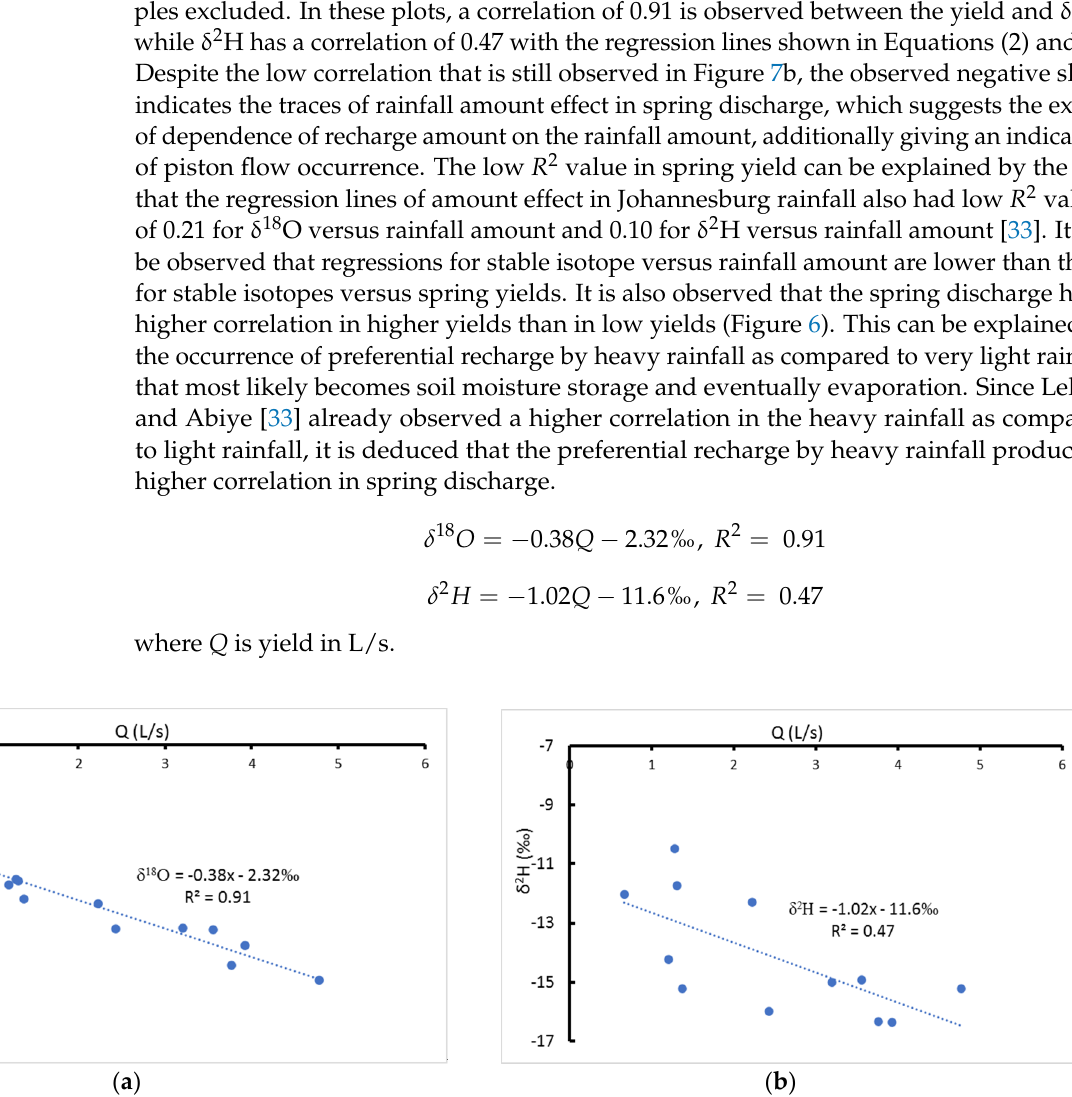
Figure 7. Plots of spring yield versus stable isotopes excluding outlier samples with ( a ) showing a correlation between yield and δ 18 O and ( b ) showing 0.47 between yield and δ 2 H.